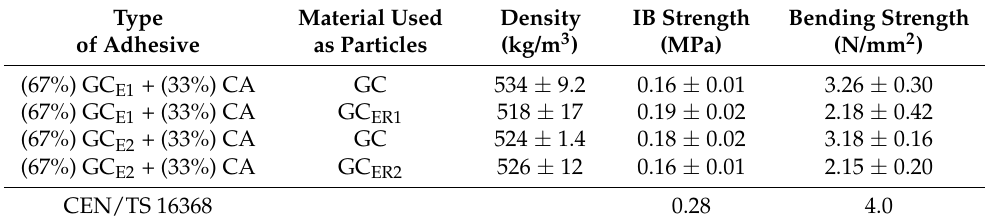
Table 9. Results for grape cane particleboards bonded with GC E and citric acid.